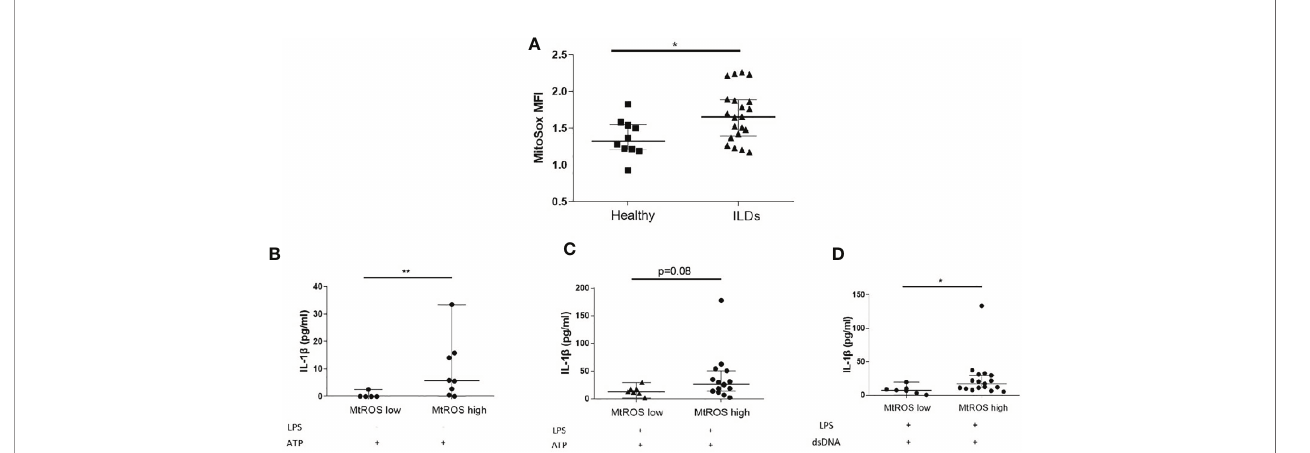
FIGURE 3 | Mitochondrial Oxidation status and the in fl ammasome. (A) MtROS Mean Florescence Intensity Index (MFI) as assessed by fl owcytometry in healthy and ILD patients. ILD Patients were categorised according to MtROS MFI using the cut-off value of 1.5(generated by ROC curve). Comparisons on in fl ammasome